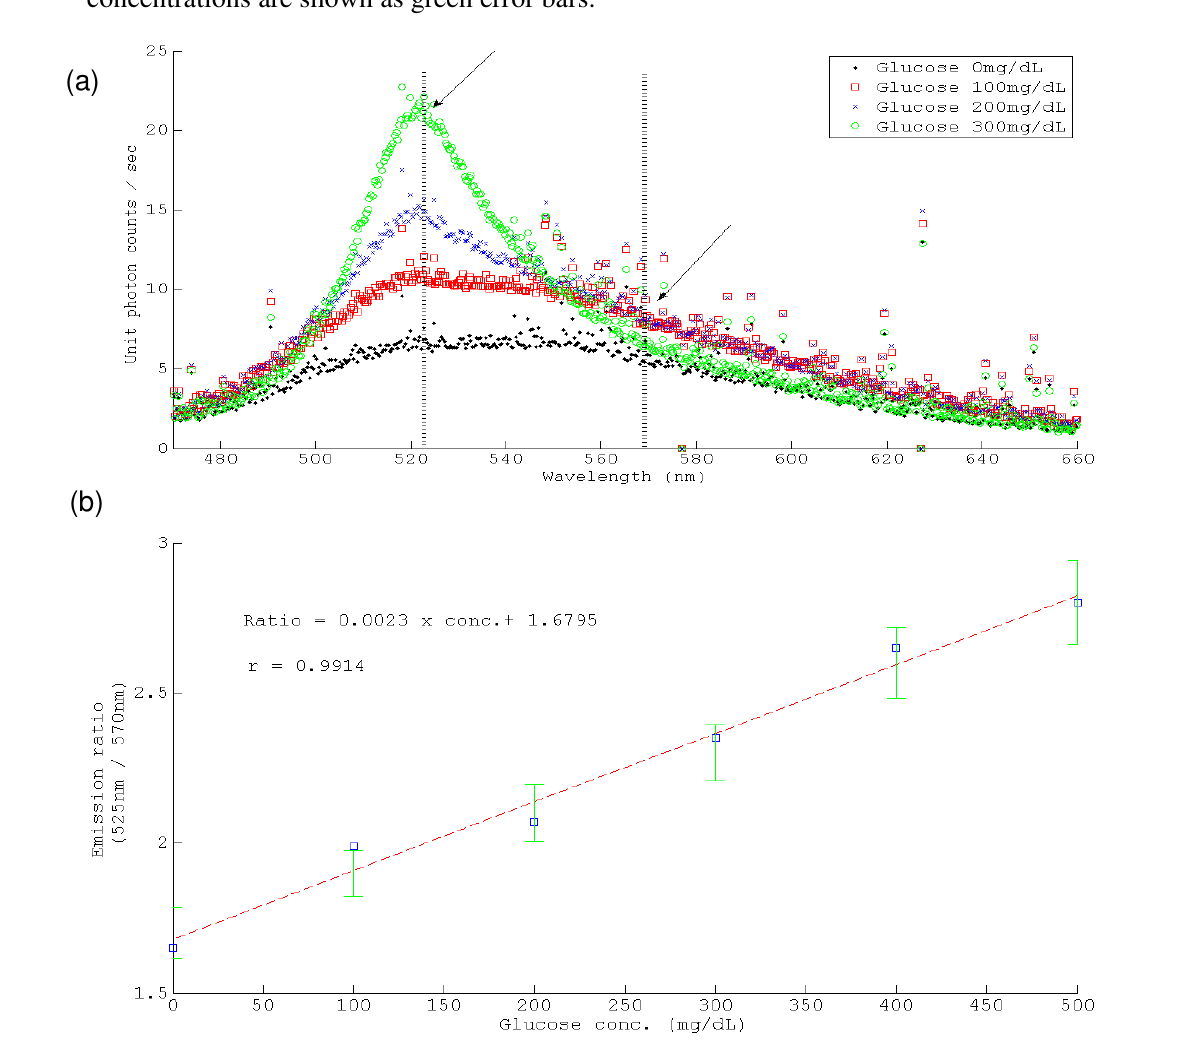
Figure 3. Sensor calibration from the linear fitting result of in vitro measurements. (a) Absolute emissions at 525 nm and 570 nm (arrows) were applied to calculate the ratio for indicating glucose concentration. (b) Linear correlation between the emission ratios and the corresponding glucose concentrations. The standard deviations (from the six sensors manufactured in the same batch) of the calibration values at corresponding glucose concentrations are shown as green error